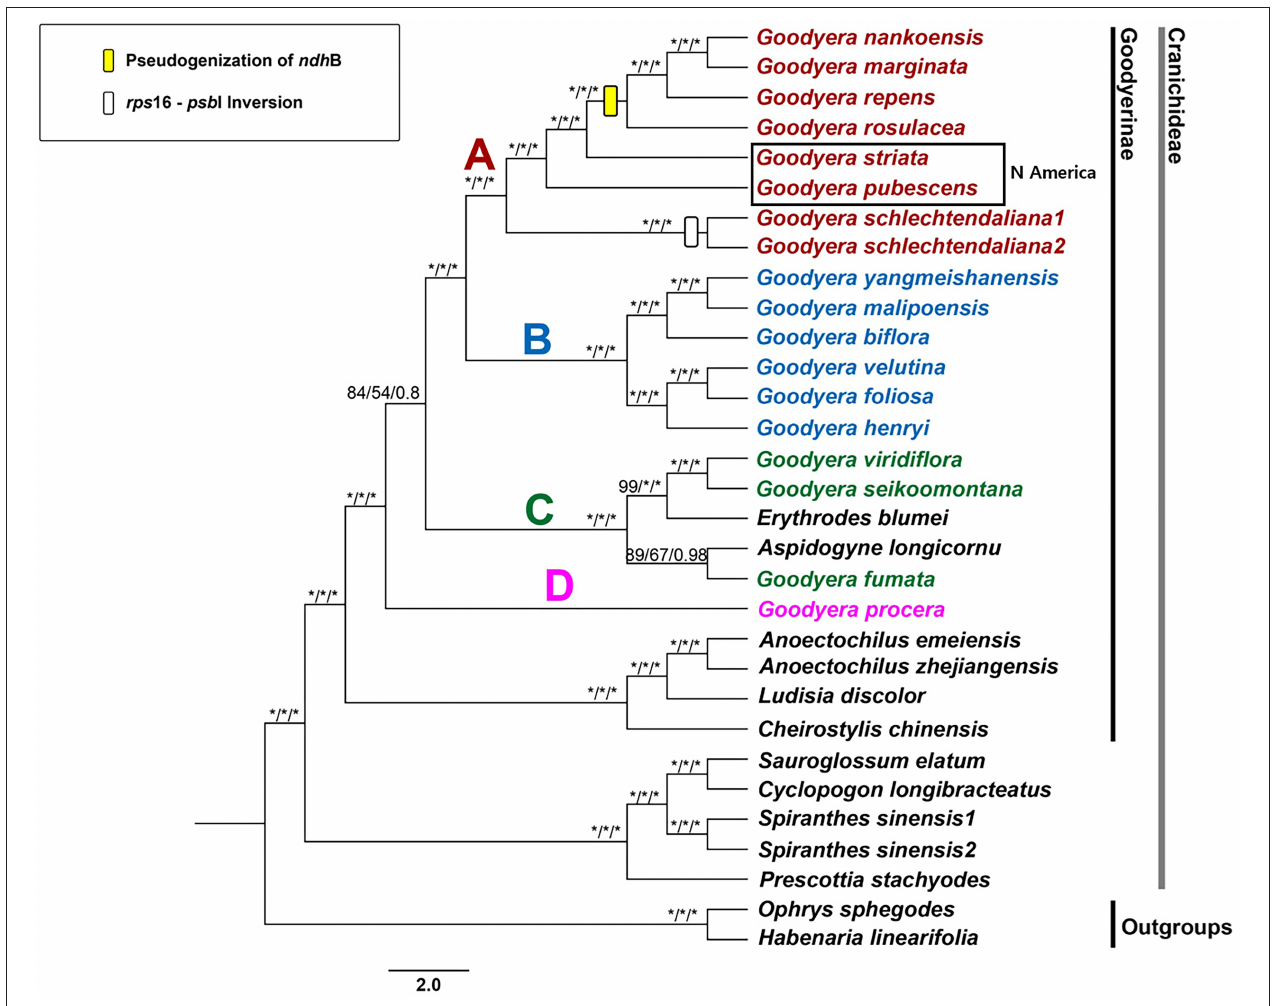
FIGURE 3 | Strict consensus tree from the MP analysis of 31 orchids inferred from 79 plastid protein-coding genes. Numbers indicate support [maximum parsimony bootstrap (PBP)/maximum likelihood bootstrap (MBP)/posterior probability (PP)]. An asterisk (*) indicates that the node has 100% bootstrap or 1.00 posterior probability. The rectangle on the branch indicates the features of the plastome